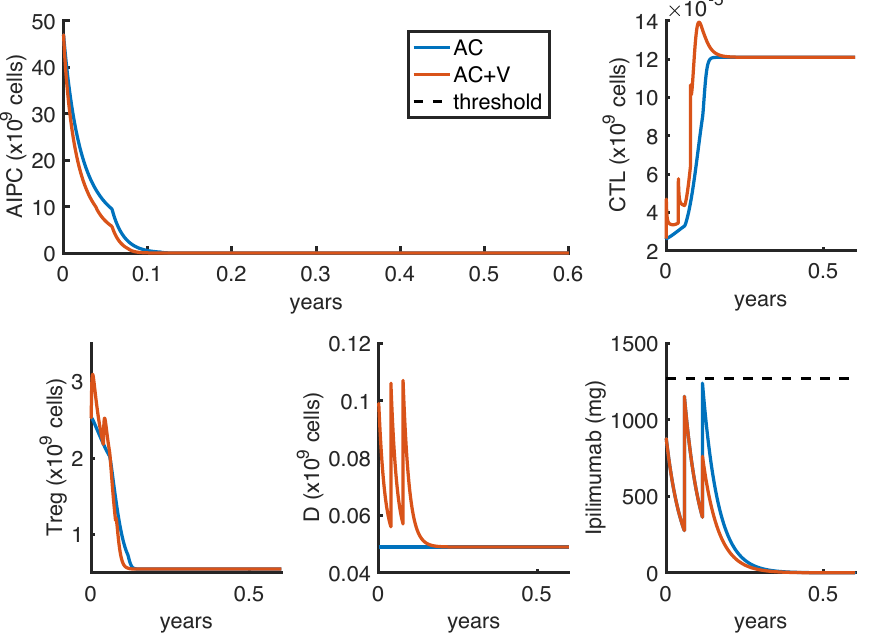
(AC+V). The ipilimumab threshold has been highlighted with a black dotted line.